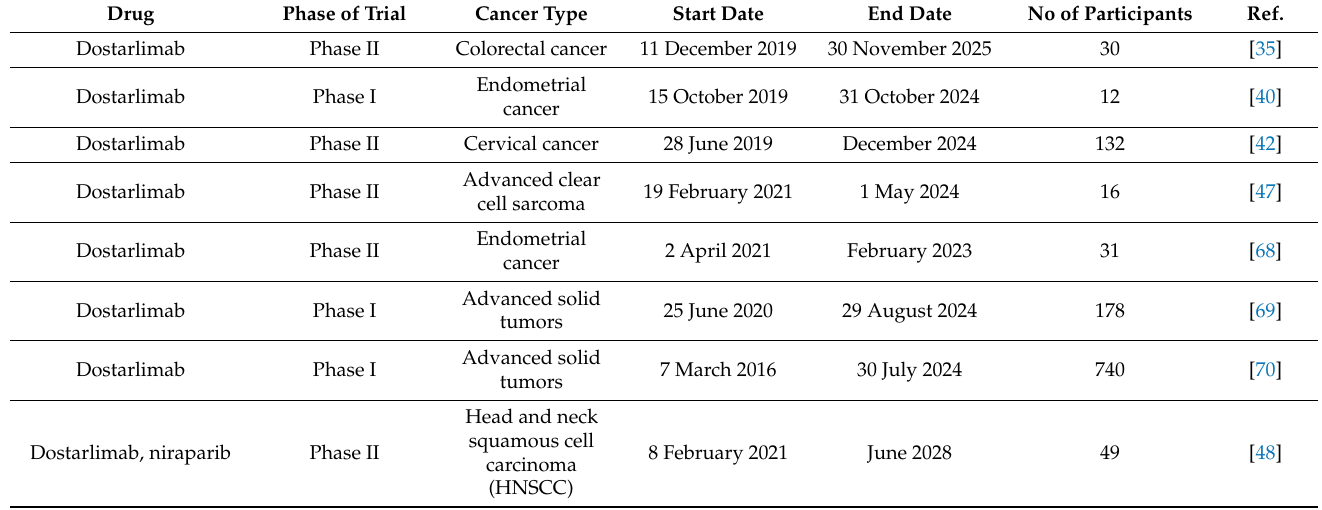
Table 1. The major clinical trial of